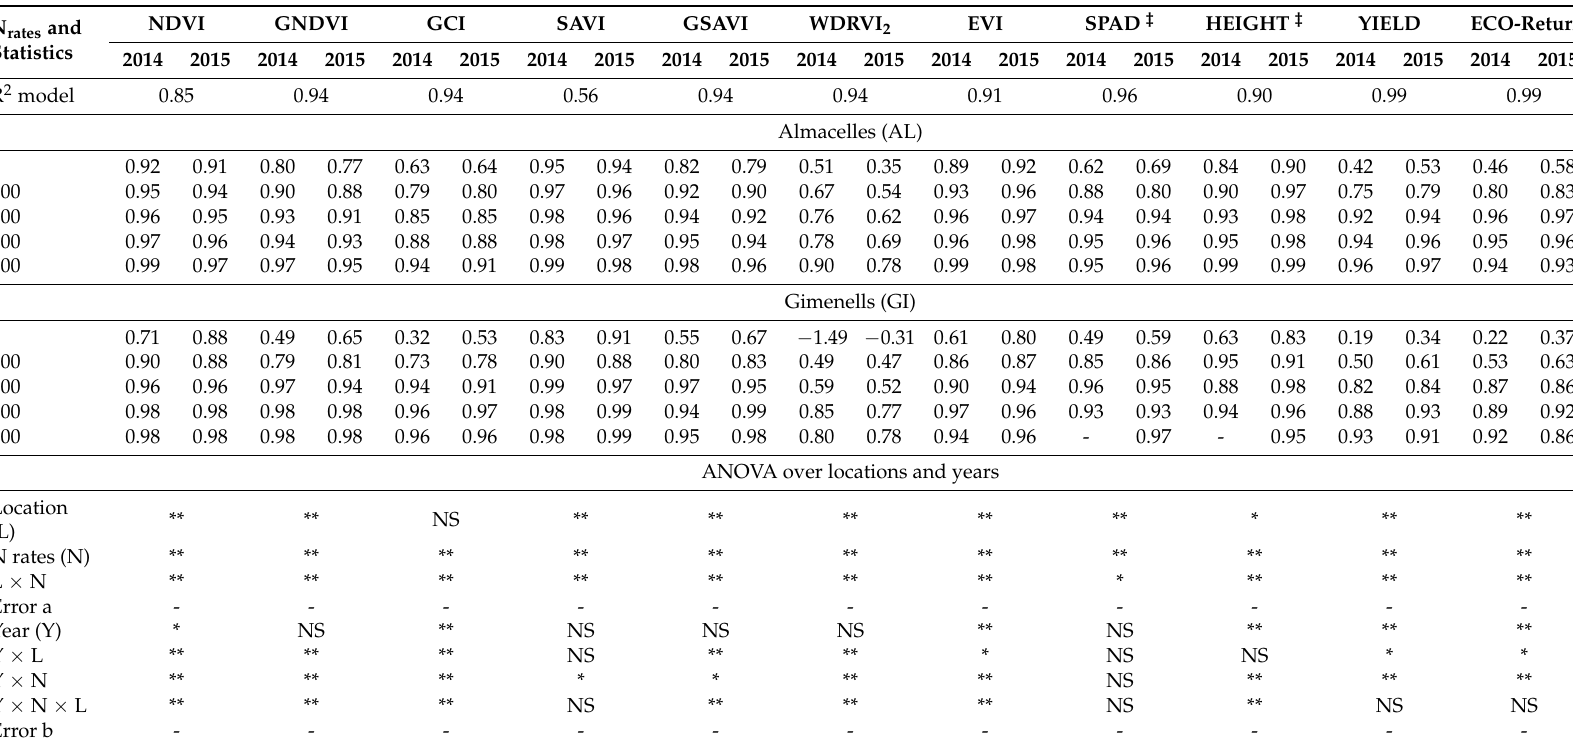
Table 3. Analysis of variance and mean values of the vegetation indices ( n = 50 for each plot), plant height ( n = 15 for each plot), SPAD ( n = 15 for each plot), yield and economic return (ECO-return) ( n = 4) for the different nitrogen rates (N rates ) in the experiments of Almacelles (AL) and Gimenells (GI) during the 2014 and 2015 growing seasons. The results are presented as ratios dividing the indices values or the yield by the maximum observed in each field and year. N rates and